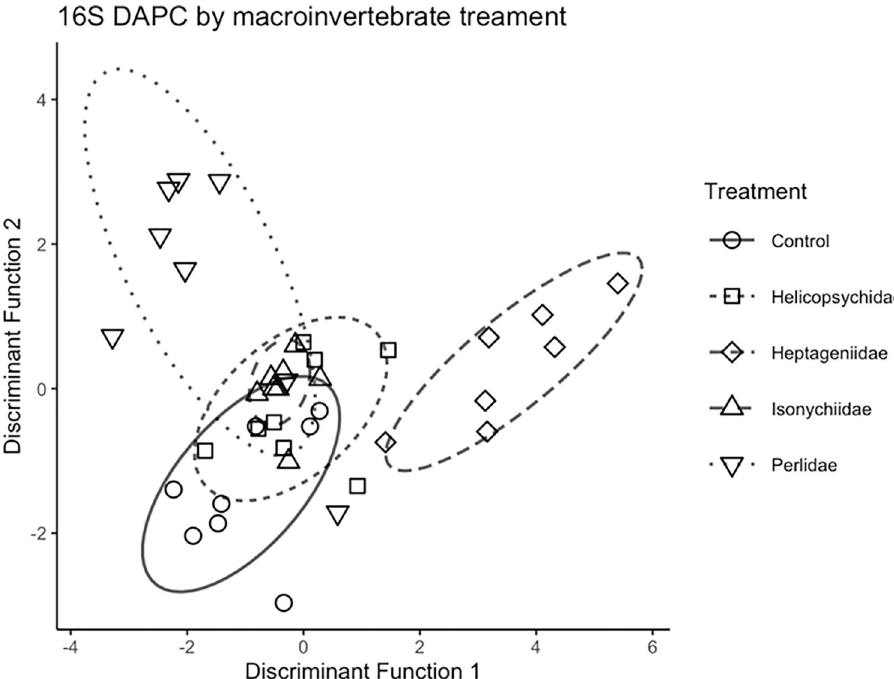
Fig 8. Multivariate ordinations of lake sturgeon egg surface bacterial (16S) communities based on discriminant analysis of principle components using Bray-Curtis distances for aquatic insect treatments sampled during time 2 (4 da post